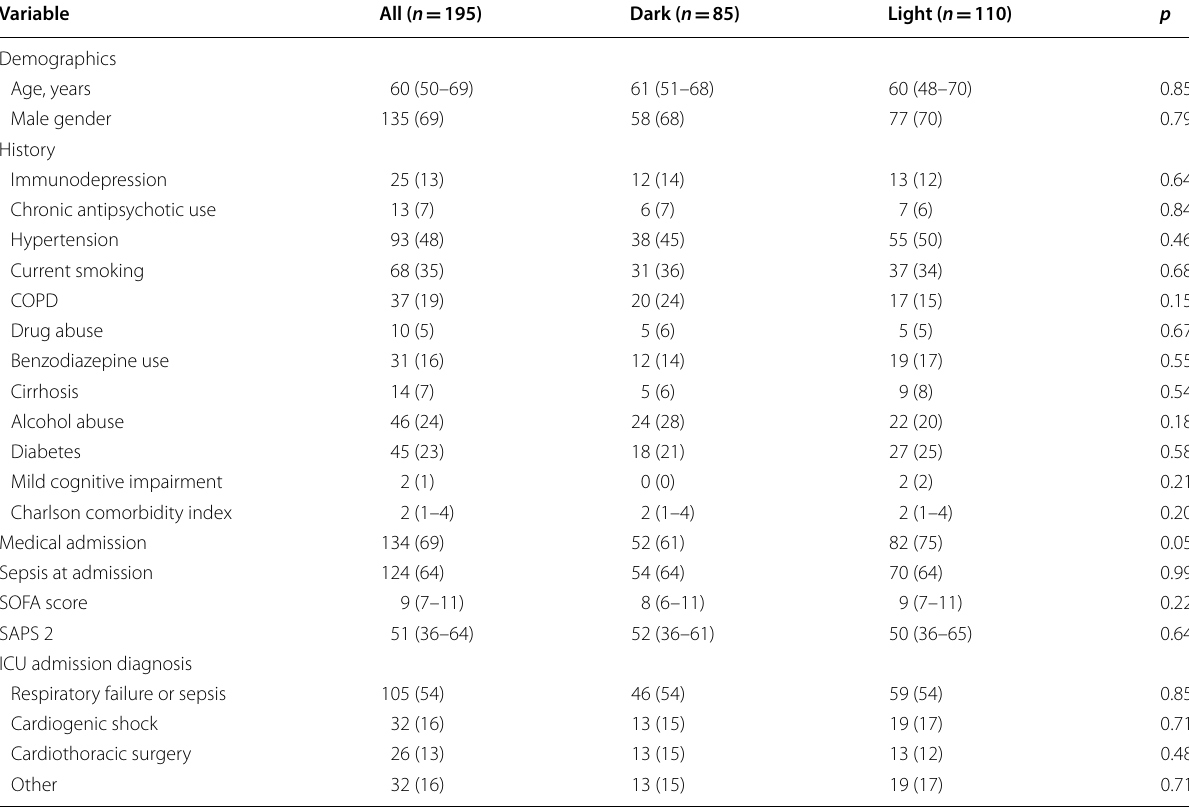
Table 1 Baseline